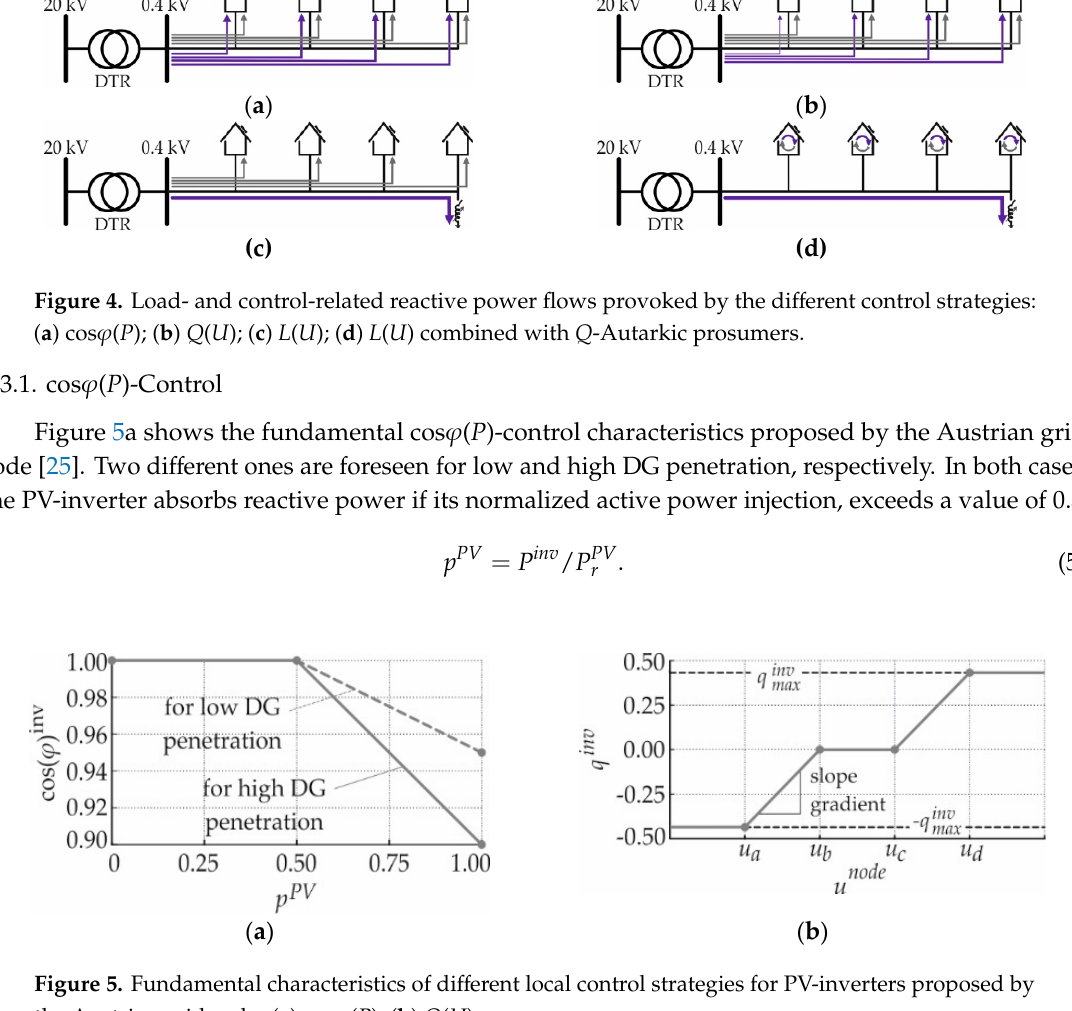
Figure 3. Structure of each prosumer.